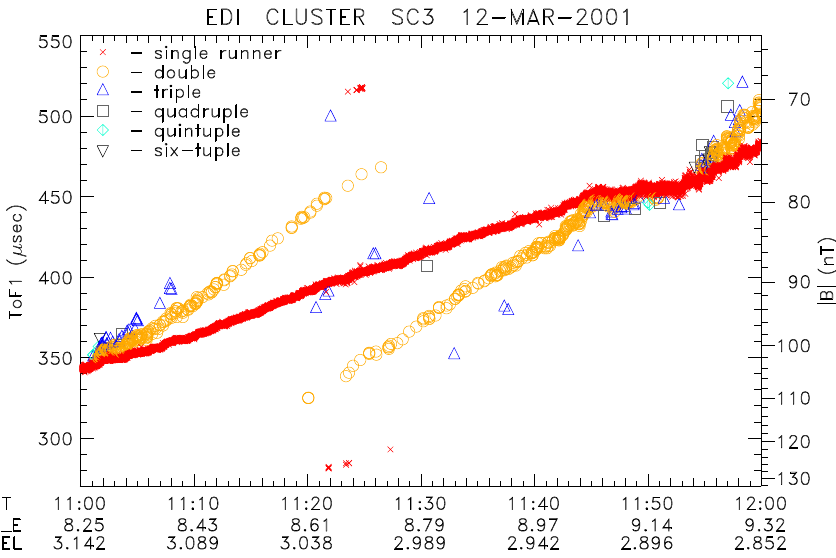
Fig. 5. Example of measured times-of-flight for Detector1. The order of the multi-runners, identified by different symbols, has been determined by the method explained in the text. The scale on the right shows the magnetic field strength computed from the